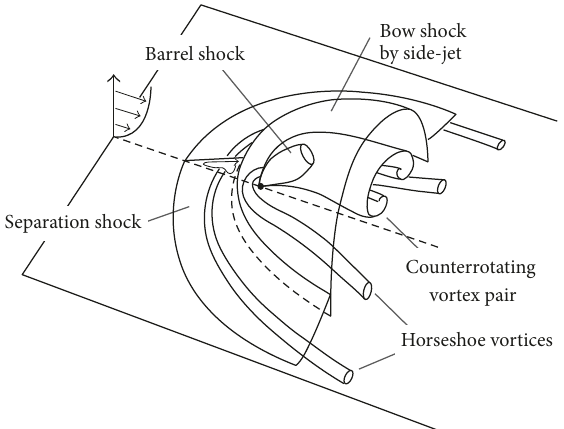
Figure 1: Schematic of a flow field associated with a single injection into hypersonic cross flow.